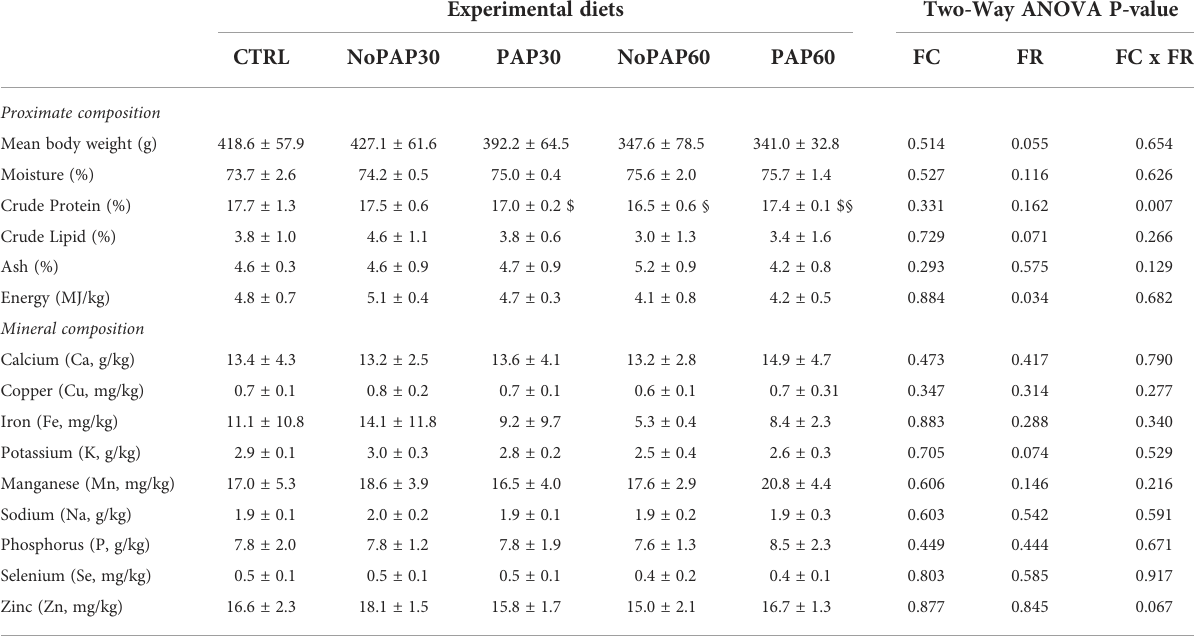
TABLE 5 Chemical composition of the fi sh carcass on wet weight basis of market-sized turbot fed with fed fi ve experimental diets. Experimental diets